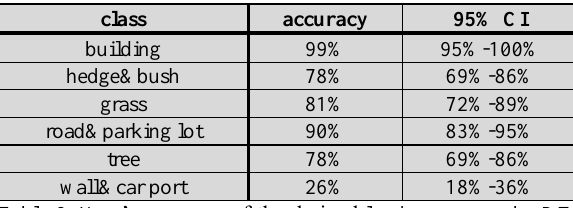
Table 3. User’s accuracy of the derived land cover map by DT-